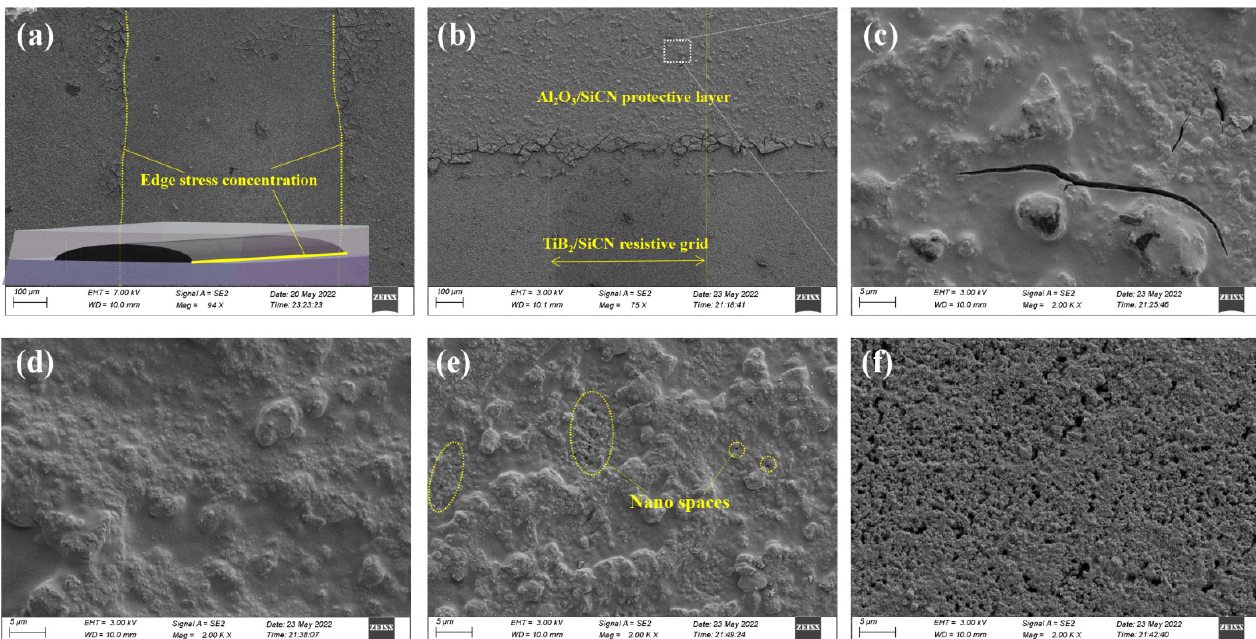
Figure 2. SEM images of ( a ) SiCN, ( b , c ) Al 2 O 3 (10 wt%)/SiCN, ( d ) Al 2 O 3 (20 wt%)/SiCN, ( e ) Al 2 O 3 (30 wt%)/SiCN, and ( f ) Al 2 O 3 (40 wt%)/SiCN.